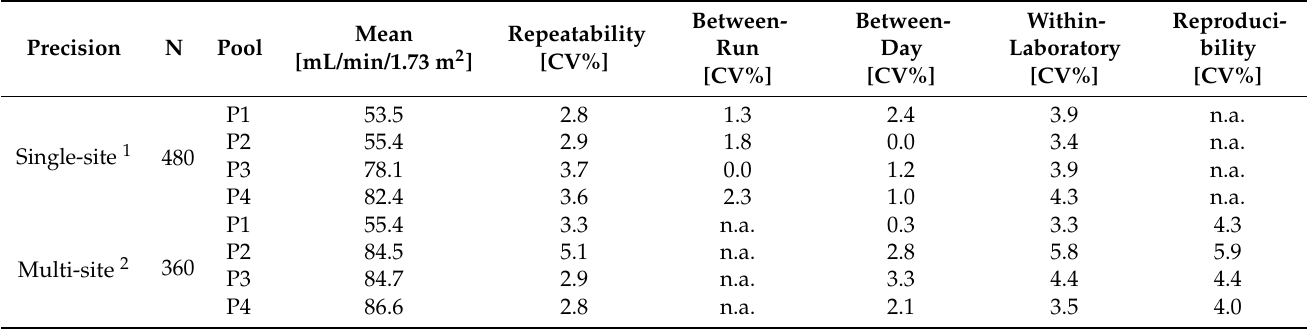
Table 2. GFR NMR single- and multi-site precision.